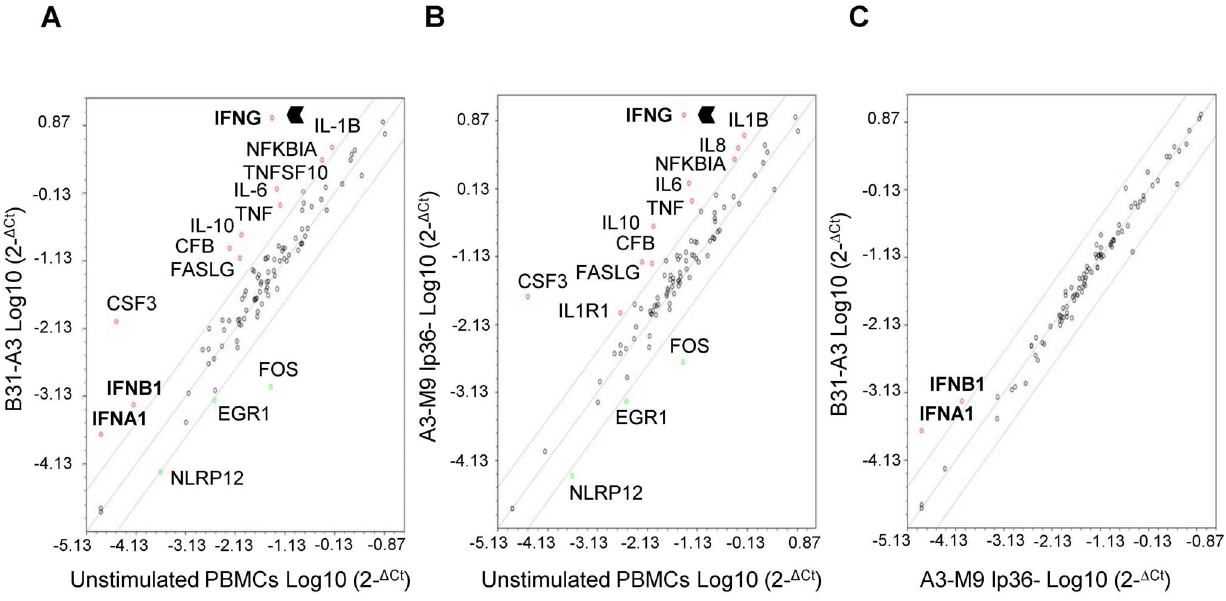
Figure 3. The absence of lp36 does not affect NF- k B-mediated signaling, but is required for transcription of ifna1 and ifnb1 . Human PBMCs (5 6 10 6 ) were co-incubated for 12 hours with 5 6 10 7 B31-A3 or A3-M9 lp36 2 . Equal amounts of PBMC total RNA from each of three biological replicates was pooled, converted to cDNA and used as a template for the Human NF- k B Signaling Pathway RT 2 Profiler PCR Array. Genes that were transcriptionally induced or repressed $ 4-fold are indicated by red or green circles, respectively. Scatter plots depict transcriptional regulation in PBMCs stimulated with B31-A3 ( A ) or A3-M9 lp36 2 ( B ) versus unstimulated PBMCs. C , Comparison of transcript profiles of PBMCs stimulated with either B31-A3 or A3-M9 lp36 2 B. burgdorferi